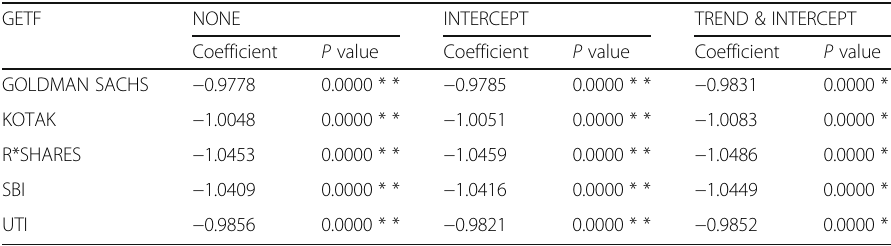
Table 3 Probability values of the unit root test GETF NONE INTERCEPT TREND & INTERCEPT Coefficient P value Coefficient P value Coefficient P value GOLDMAN